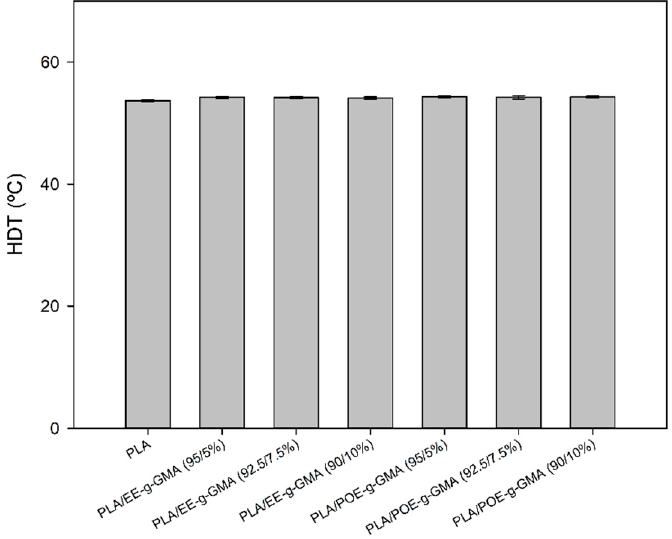
Figure 10. Heat deflection temperature of pure PLA and blends containing 5; 7.5 and 10% of EE-g- GMA and POE-g-GMA.